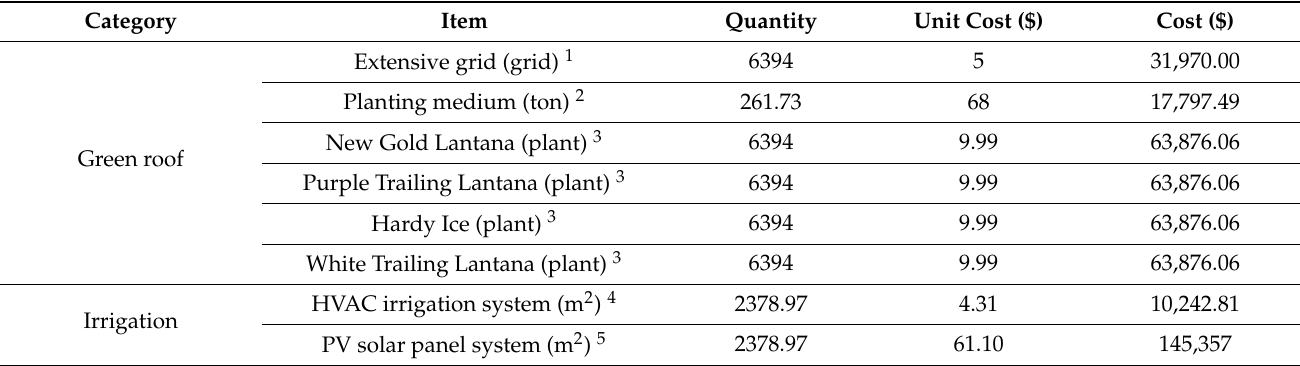
Table 4. Cost analysis of the green roof